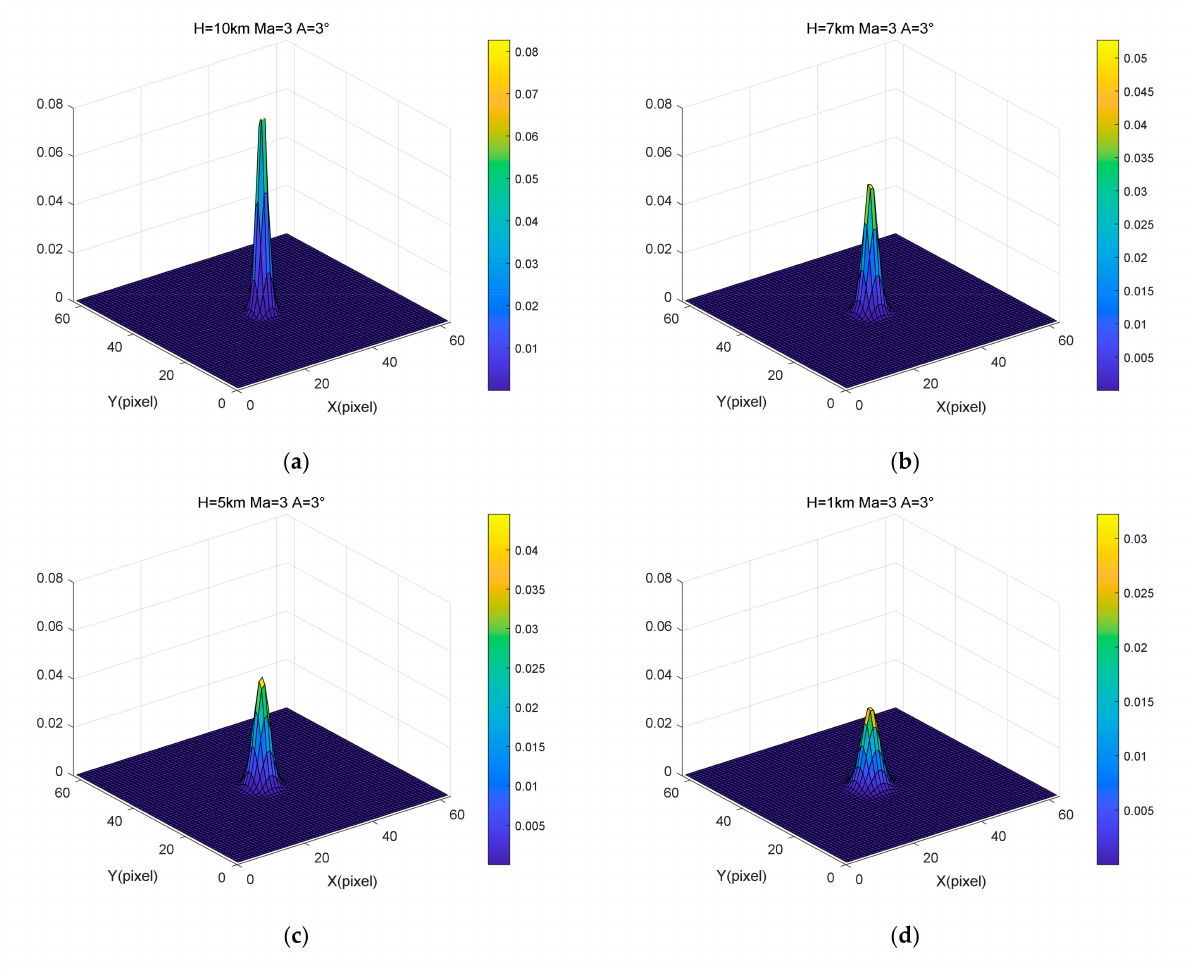
Figure 6. Variations in PSF results with different heights: ( a ) Mach number = 3, Angle of attack = 3 ◦ , Height = 10 km, ( b ) Mach number = 3, Angle of attack = 3 ◦ , Height = 7 km, ( c ) Mach number = 3, Angle of attack = 3 ◦ , Height = 5 km, ( d ) Mach number = 3, Angle of attack = 3 ◦ , Height = 1 km.